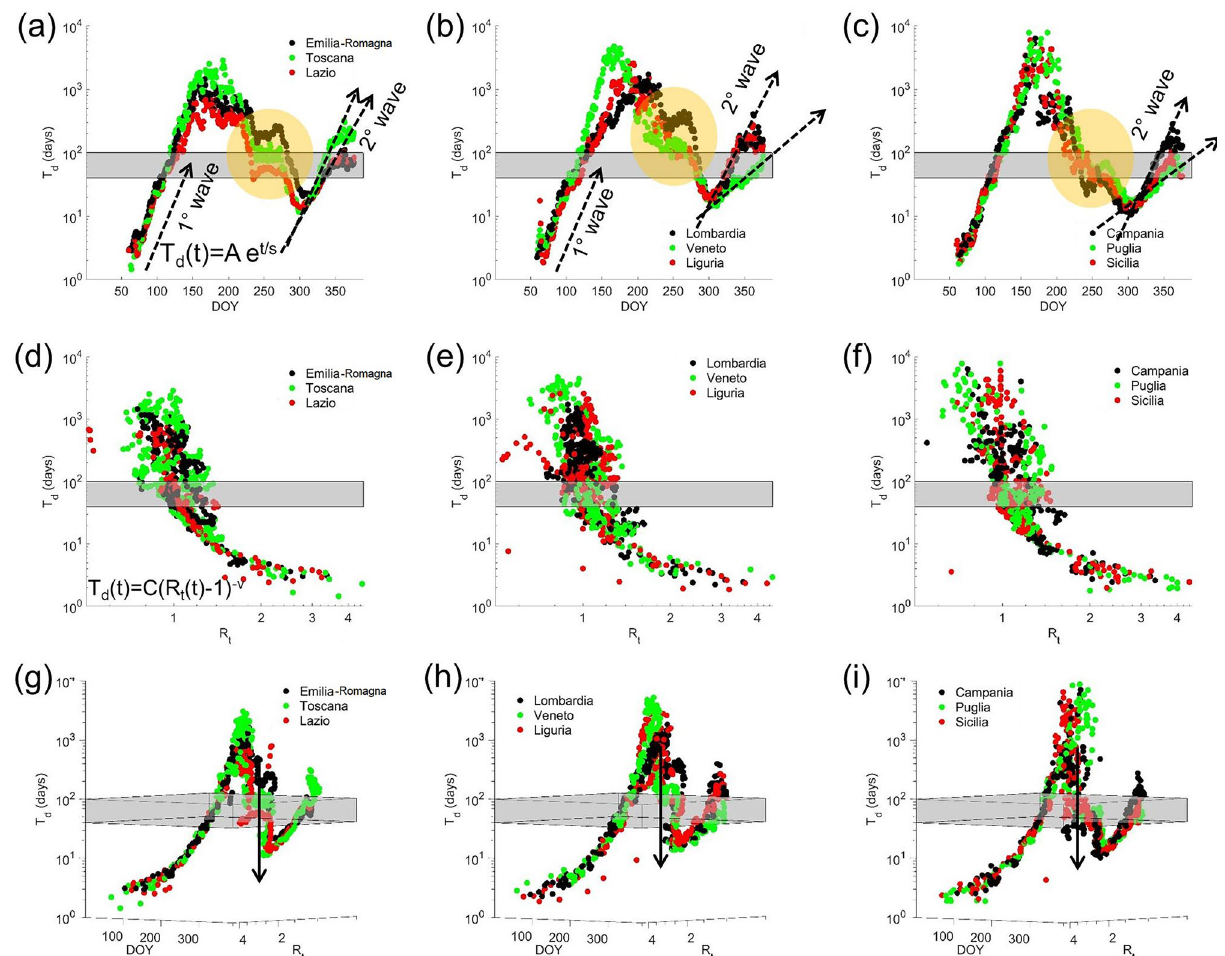
Figure 2. The (T d , R t , t) 3D phase diagram for several Italian regions. The planar semi-logarithmic projection (T d , t) for three different groups of regions are shown in panel ( a ), ( b ) and ( c ). The 1st and 2nd waves obeying the exponential growth [T d (t) = Ae t/s ] are outlined by dashed arrows in the supercritical regime. Since the growth rate is described by the s -factor, in the 1st wave the exponential epidemics growth is the same for all regions. On the contrary, the 2nd wave exhibits different growth rate due to the different s -factor [dashed arrows], with different slopes. The orange areas outline the disordered metastable phases above the critical regime (grey rectangle) and the precursors of the 2nd phase. The panels ( d ), ( e ) and ( f ) are the (T d , R t ) projections showing the universality of the scaling law T d (t) = C(R t (t) − 1) −ν in the supercritical phase in all regions. Also in this case we observe the arrested and metastable disordered phases above the critical phase. Finally, in panels ( g ), ( h ) and ( i ) are showed the (T d , R t , t) 3D phase diagram of three groups of Italian regions to recognize the different metastable phases all ending around the raising point of the 2nd Metastable phases in the plateaus before and after the second wave in Italy and Italian regions. The Covid-19 spreading rate with containment measures (CSRwCM) in a heterogeneous popula- tion can be understood in more detail looking at the analysis and the comparison of the pandemic spreading rate in the different Italian regions. Figure 2 shows the 3D (T d , R t , t) phase diagram for three sets of Italian regions where different metastable phases can be recognized. We have combined Emilia Romagna, Toscana and Lazio (left panels), Lombardia, Veneto, and Liguria (central panels), Campania, Puglia and Sicilia (right panels). The semi-logarithmic projection (T d , t) for these groups of regions are shown in Fig. 2a–c. Again, in the supercritical regime, 1st and 2nd waves obey the exponential growth of the Eq. (1) as indicated by dashed arrows. Since the growth rate is described by the s -factor, we point out that in the 1st wave the exponential epidemics growth is the same for all regions. On the contrary, the 2nd wave exhibit different growth rate, as indicated by the dashed arrows, and are characterized by different s-factors and different slopes. This is due by the different containment measures enforced by the local governments. The orange areas identify the disordered metastable phases above the critical regime (grey rectangle) with the precursor states of the 2nd phase. Figure 2d–f are the (T d , R t ) projections confirming the universality of the scaling law in Eq. 2 in the supercritical phase, in all regions. Also in this case, above the critical phase we identify